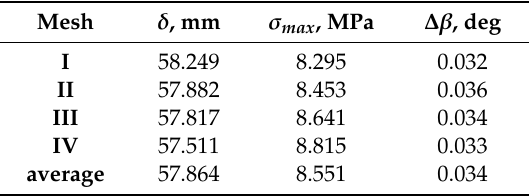
Table 5. Mesh convergence study